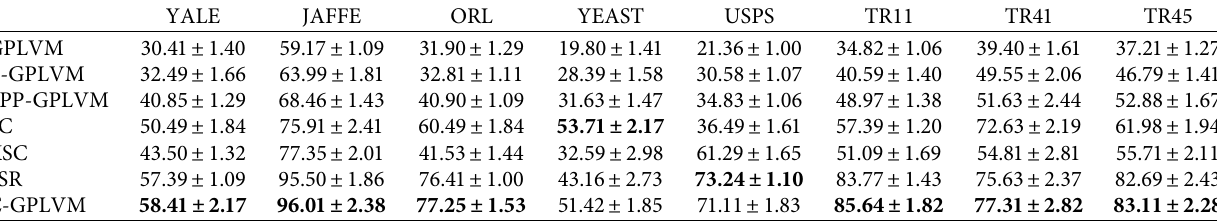
Table 4: Normalized mutual